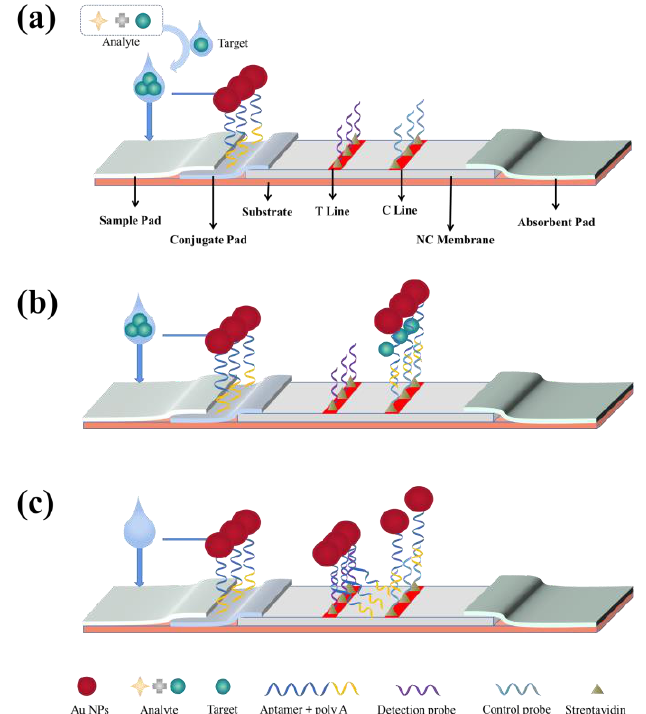
Figure 3. Schematic diagram of the operation principle of a typical competitive-type test strip. ( a ) Competitive lateral flow test strip. ( b ) Reactions occurring in a competitive lateral flow test strip in the presence of the target. ( c ) Reactions occurring in the competitive lateral flow test strip in the presence of no target.